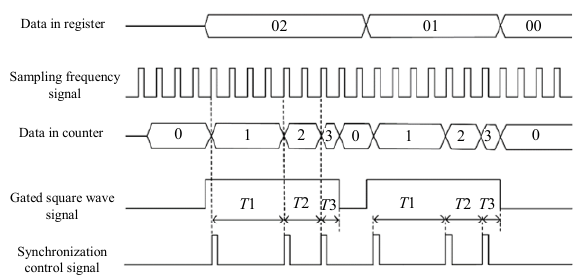
Fig. 3 Diagram of generated synchronization control signal sequence based on FPGA. The proportion distribution of time interval is T 1: T 2: T